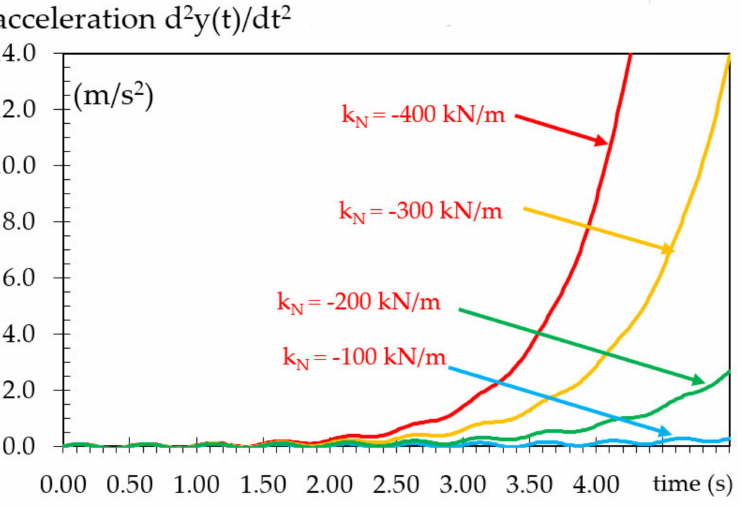
Figure 7. Response velocities of SDoF oscillators with different values of negative stiffness.